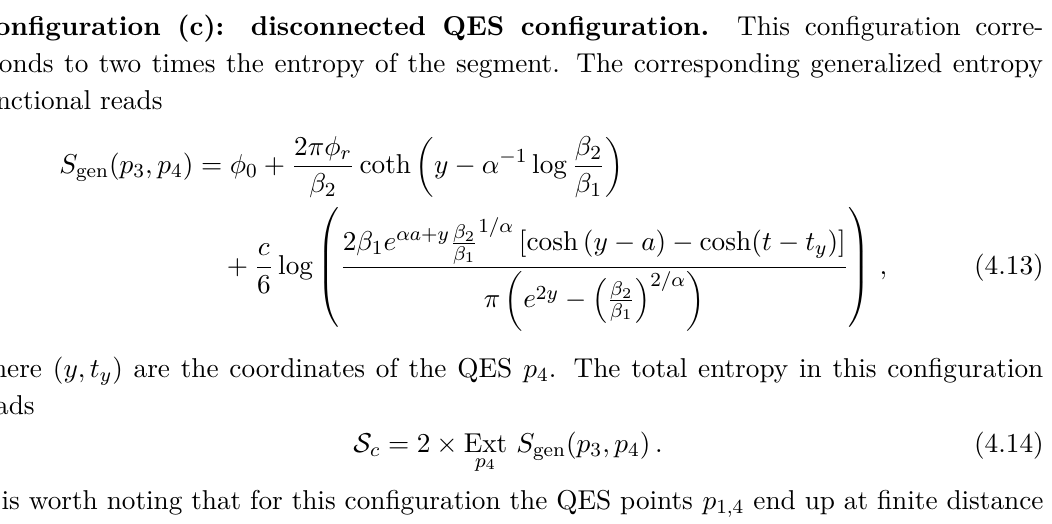
+ 0 . 01 L , β = 1 , φ = 10 c and 1 R 1 0 6 = 1 . 3 . The island phase 2